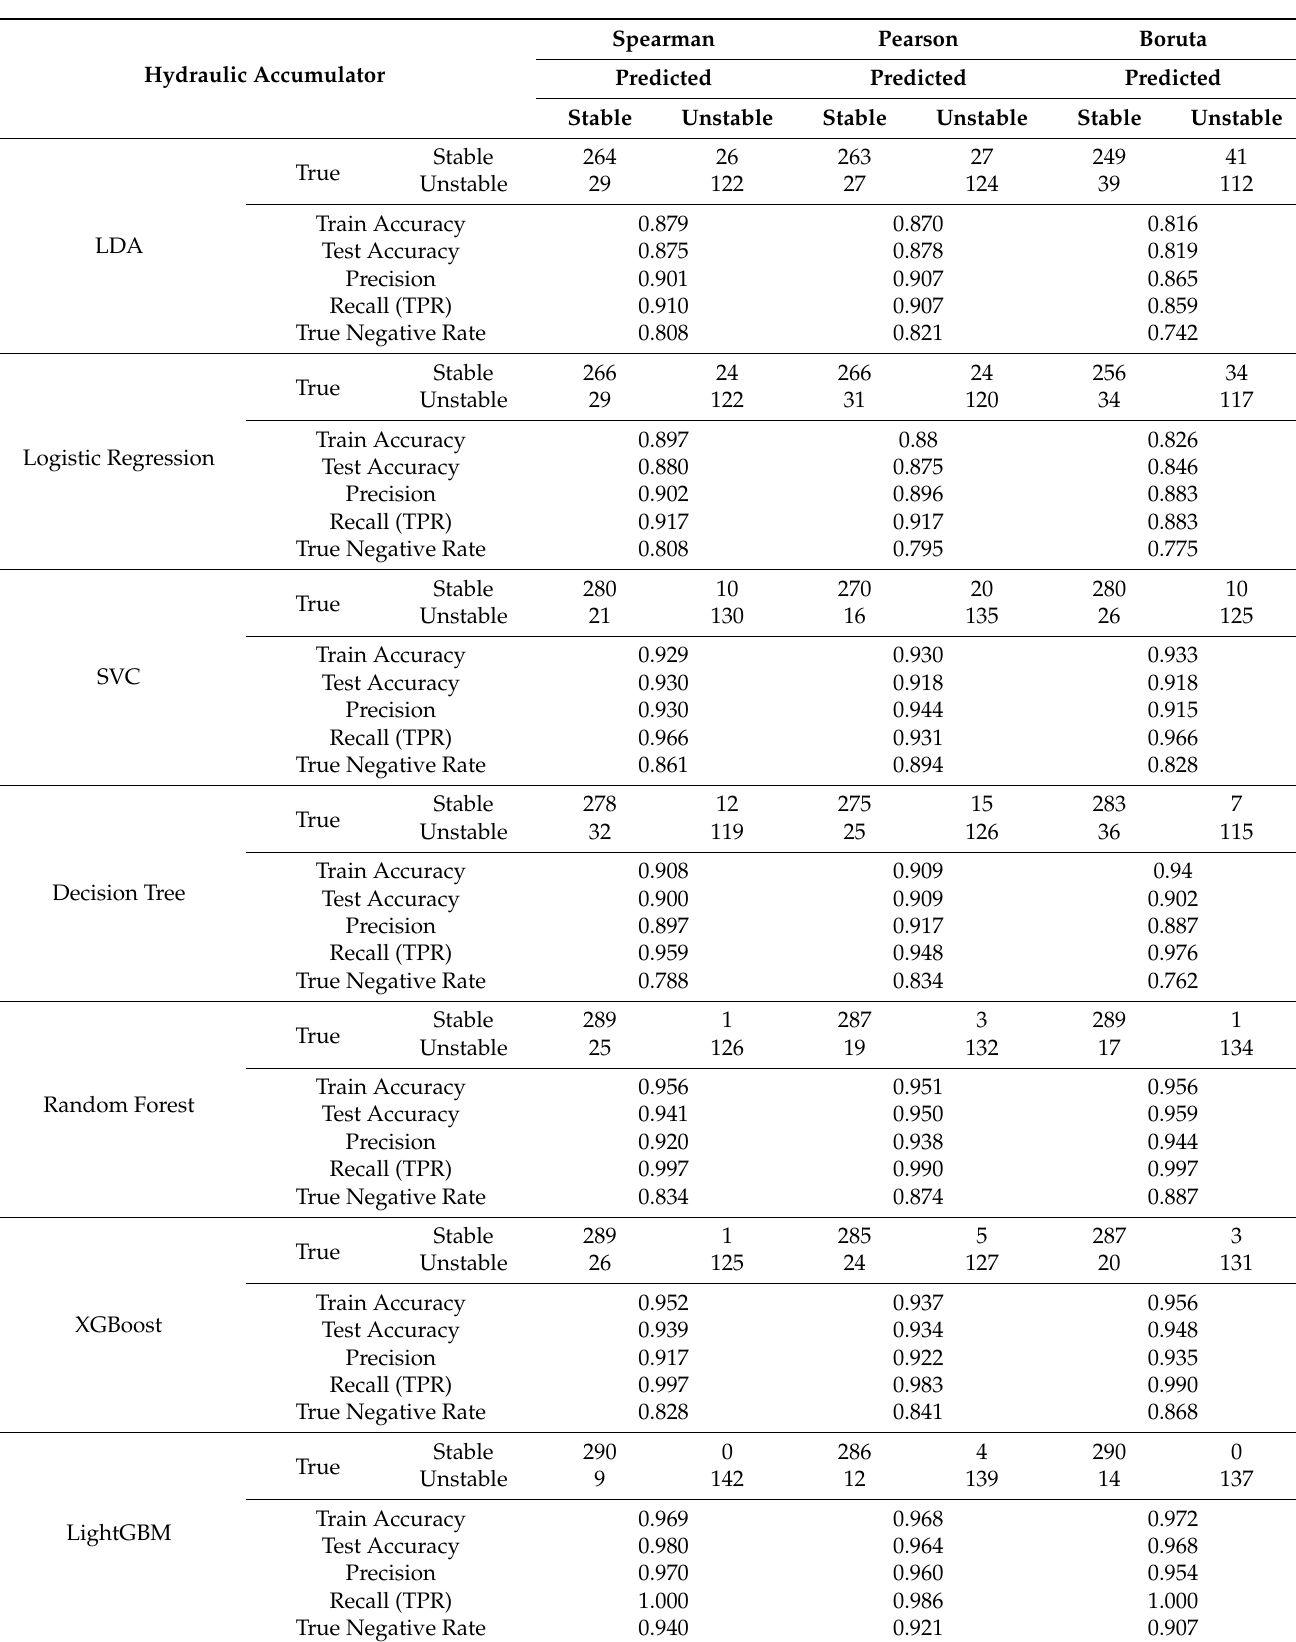
Table 12. Classification evaluation metrics for hydraulic